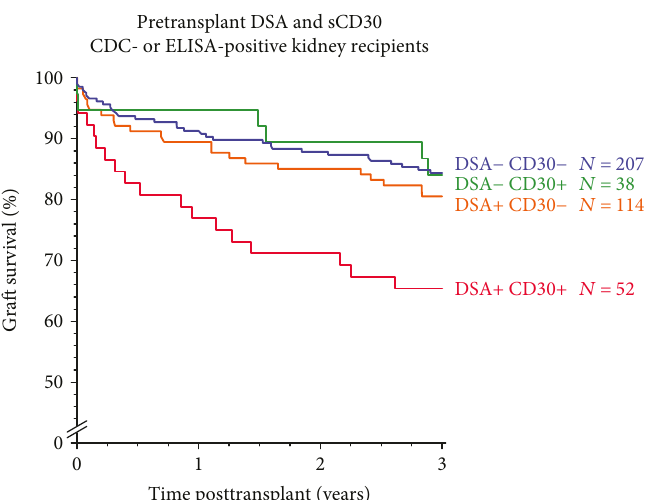
Figure 4: Impact of pretransplant sCD30 on graft survival in patients with and without pretransplant donor-speci fi c HLA antibodies (DSA) in single-antigen bead testing. An update of the results from [7] is